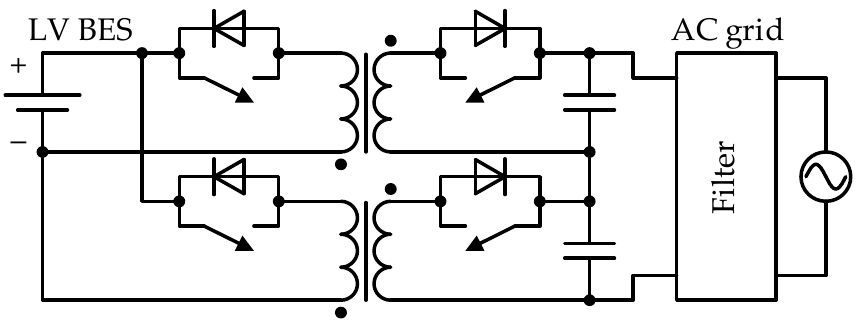
Figure 8. Inverter with a high-frequency transformer derived from a flyback converter.